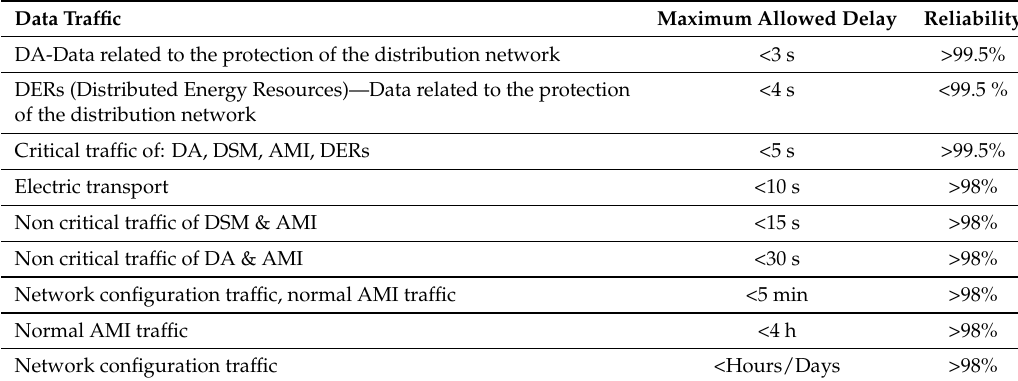
Table 1. NAN requirements in terms of reliability